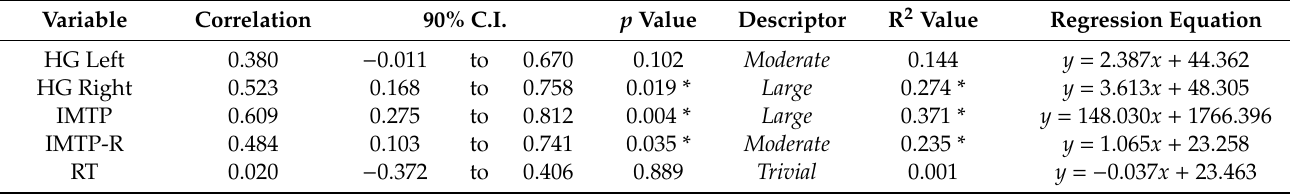
Table 1. Correlation coe ffi cients between Polo handicap and strength and reaction time (RT). Accompanying 90% Confidence intervals (C.I.), p values and magnitude descriptors are also shown. Variance explained (R 2 ) and the linear regression equations are also presented for each variable, as per Polo handicap. HG: